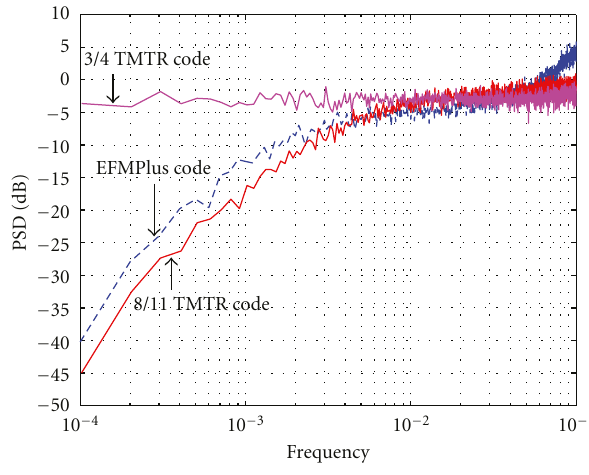
Figure 5: Power spectral density.